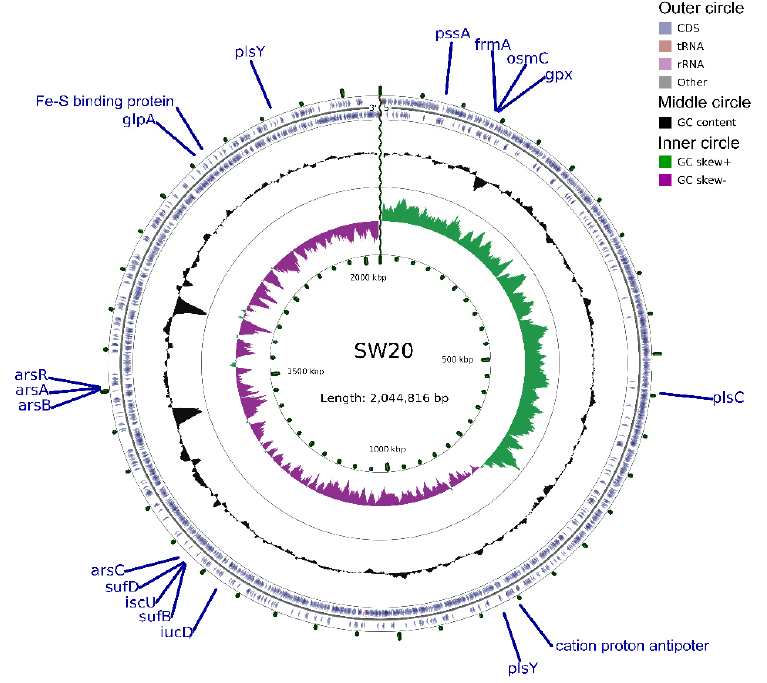
Figure 2. Circular representation of genome and features of E. aurantiacum SW-20. The contents of the featured rings (starting with the outermost ring to the center) are as follows. From the outside to the inside, outer circle contains CDS, tRNA and rRNA on the positive and negative strands respectively. The middle circle indicates that the GC% content in this region is higher than the average GC% content of the whole genome, and the higher the peak value is, the greater the difference between the region and the average GC% content is. The inward part indicates that the GC% content in this region is lower than the average GC% content of the whole genome, and the higher the peak